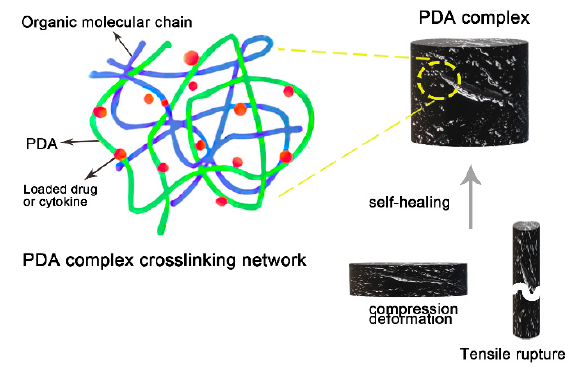
Figure 2. Self-healing of PDA complex hydrogel.